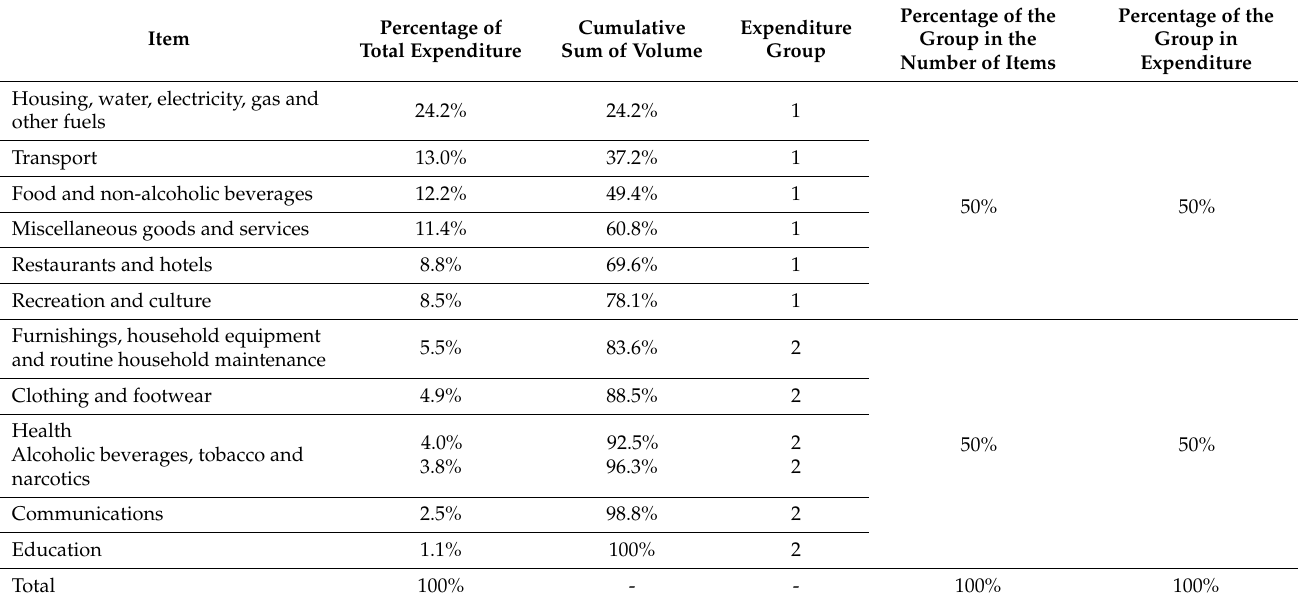
Table 1. Household expenditure in the countries of the EU in 2017. Source: created by authors according to data from [61]. Item